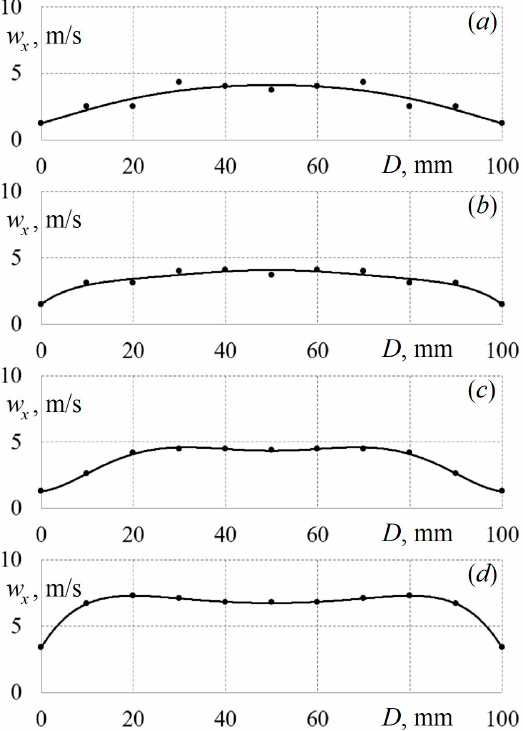
Figure 5. Change in local values of the flow velocity w x along the cylinder diameter D when air is supplied to the diffuser through round tubes for the initial average flow velocity in the first section w 1 ≈ 6.31 m/s along the set-up height: ( a )— H 4 = 800 mm; ( b )— H 3 = 500 mm; ( c )— H 2 = 300 mm; ( d )— H 1 = 100 mm.